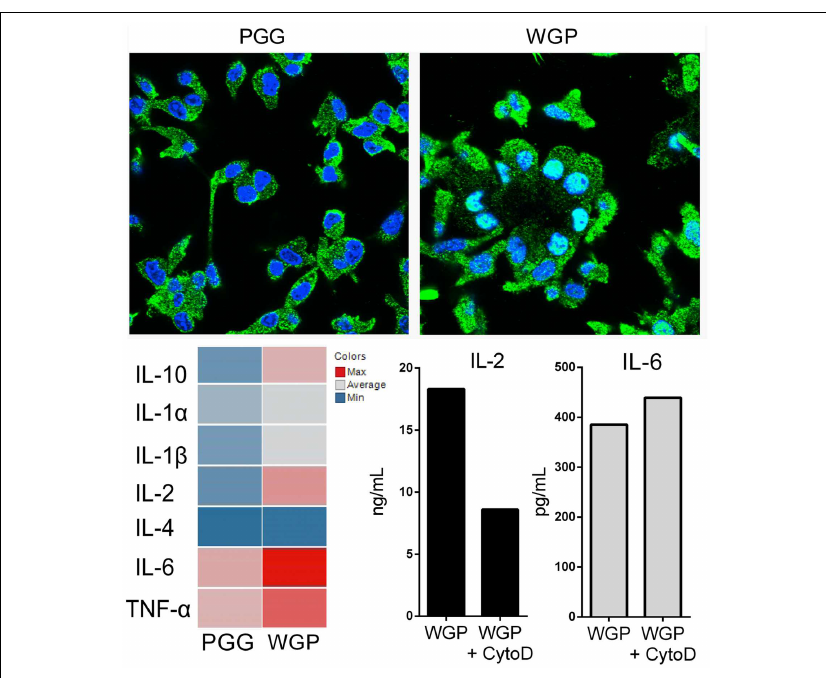
FIGURE 1 | Confocal microscopy of NFAT1 translocation in dendritic cell line (D1) upon treatment with 1,3- β glucan in both soluble form PGG (left) and aggregate of particlesWGP (right) . Both treatments lead to a different specialized cytokine pattern (bottom, left) measured by Luminex assay uniquely dependent on ligand solubility and indeed on the activation of mechanisms of endocytosis or frustrated phagocytosis. Blue, DAPI; Green, NFAT.The blocking of phagocytic process with Cytochalasin D results in inhibition of NFAT dependent cytokine (IL-2) while NF κ B controlled response remain unchanged (IL-6), as detected in supernatants of D1 cells stimulated with particulate 1,3- β glucan (bottom,